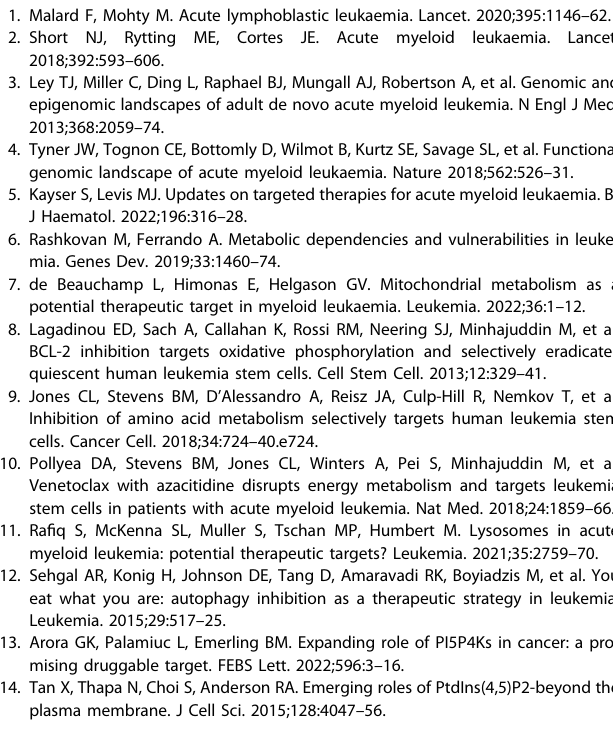
our data shed light on a new class of drugs to increase the range of treatment options for leukemia. DATA AVAILABILITY All the data were available from the corresponding author upon request. LFQ